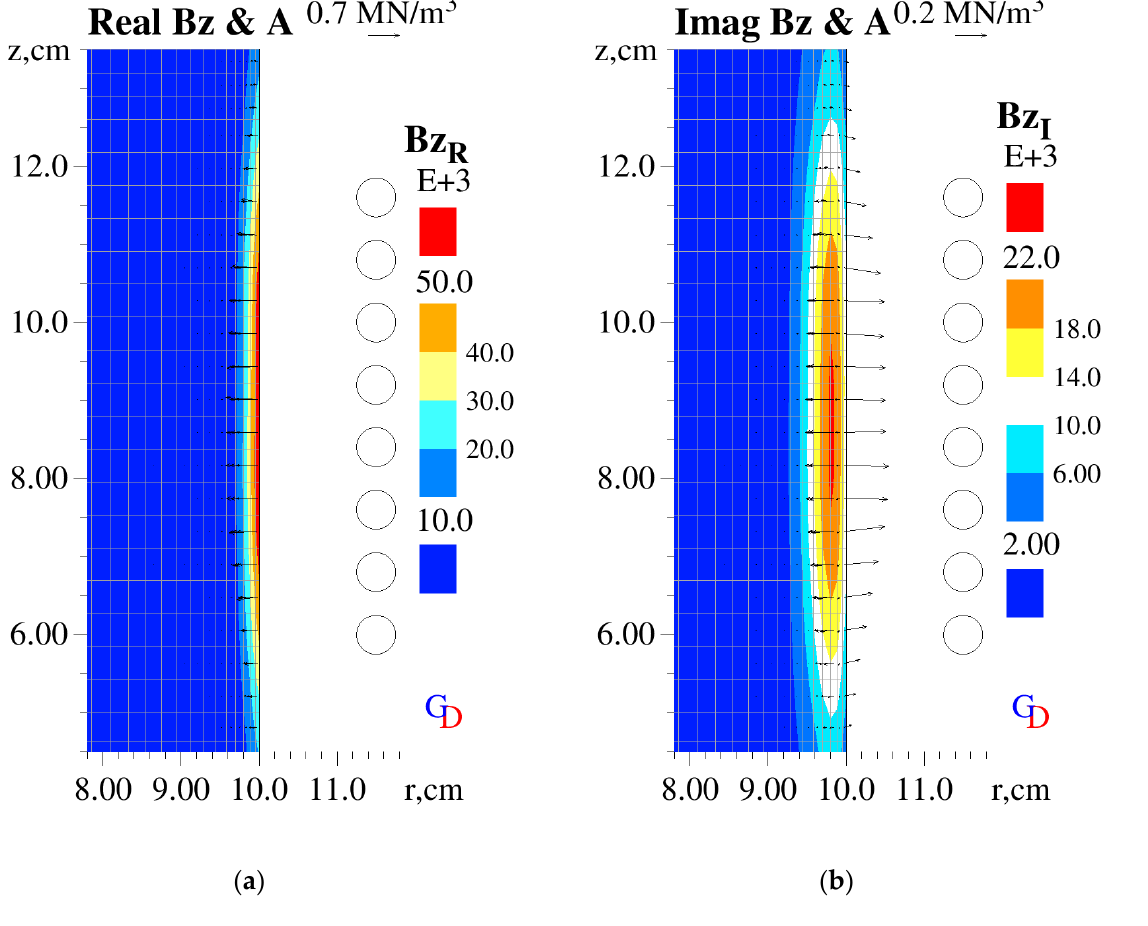
Figure 3. Computed vertical component of magnetic induction (Bz, coloured contours, in mT) and amplitude of the oscillatory component of the Lorentz force vector (A, arrows): ( a ) real parts; ( b ) imaginary parts.